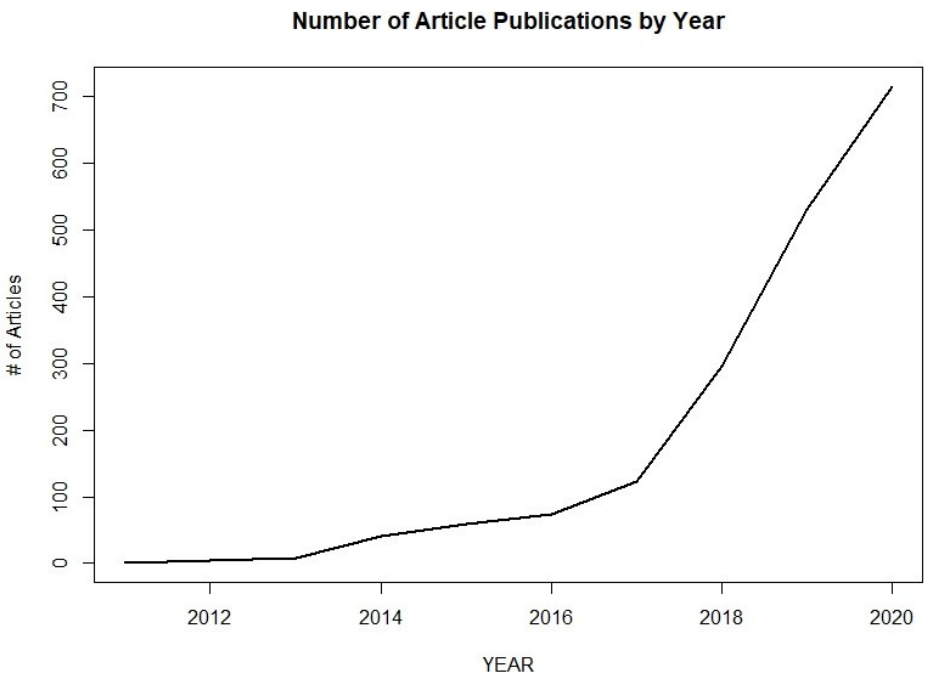
Figure 2. Number of article publications by year. Table 3. Main research areas of Bitcoin studies.